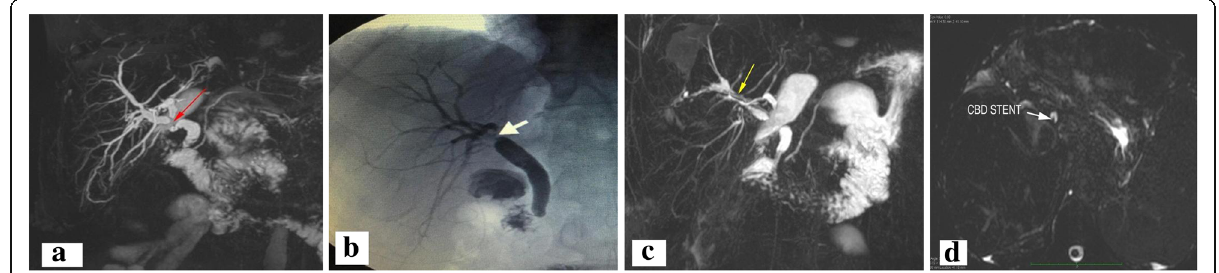
Fig. 7 A 55-year-old male 5 months after liver transplantation with duct-to-duct anastomosis. MRCP 3D MIP reconstructed coronal image showed the presence of moderate anastomotic biliary stricture (red arrow) ( a ), ERCP was done revealing the same biliary stricture ( b ), managed by CBD stent insertion (yellow arrow) ( c ) with MRCP follow-up one month interval showing no intrahepatic biliary dilatation ( d